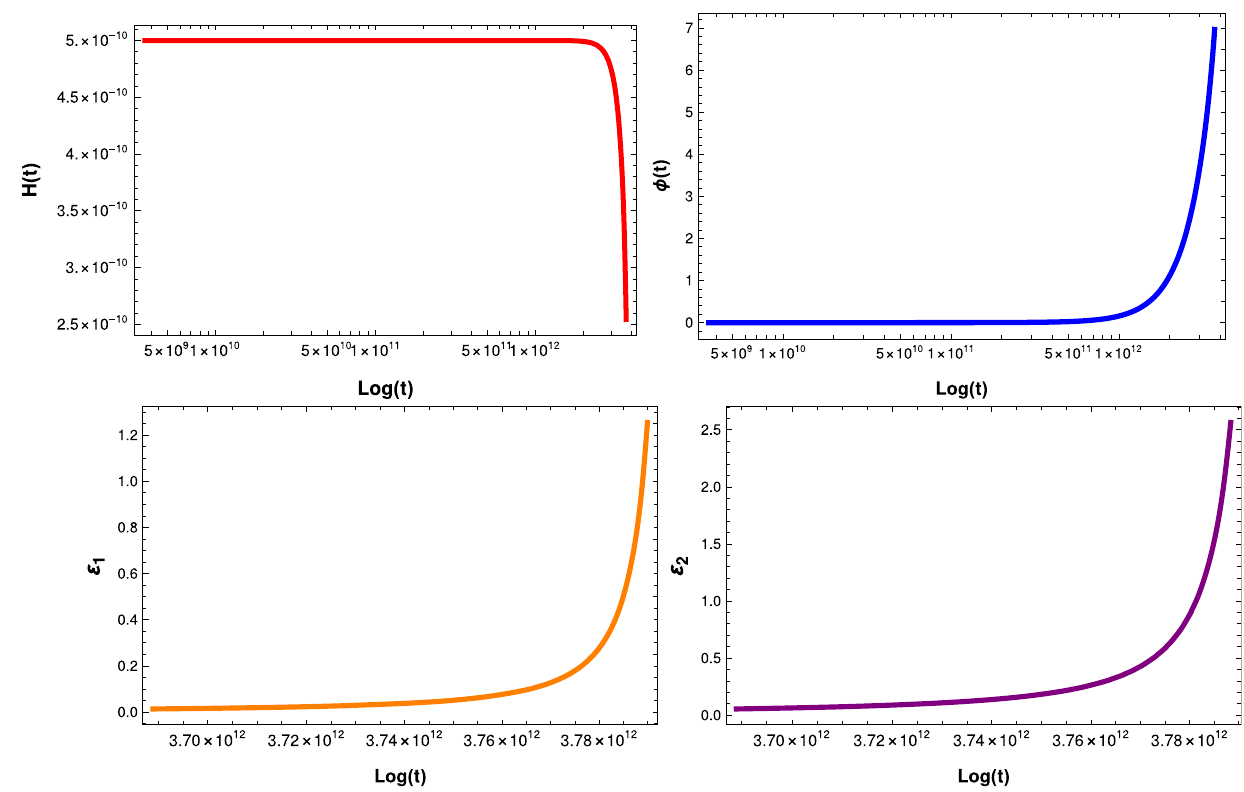
Fig. 1 Time evolution of the Hubble parameter, of the scalar field φ , and of the Hubble slow-roll parameters (cid:8) 1 and (cid:8) 2 in the case where α = 2 and n = 3. Initially, and for a suitable time interval, (cid:8) and thus according to (2.10)–(2.12) H is almost constant, which corre- (cid:8) i remain smaller than 1 are considered non-physical),